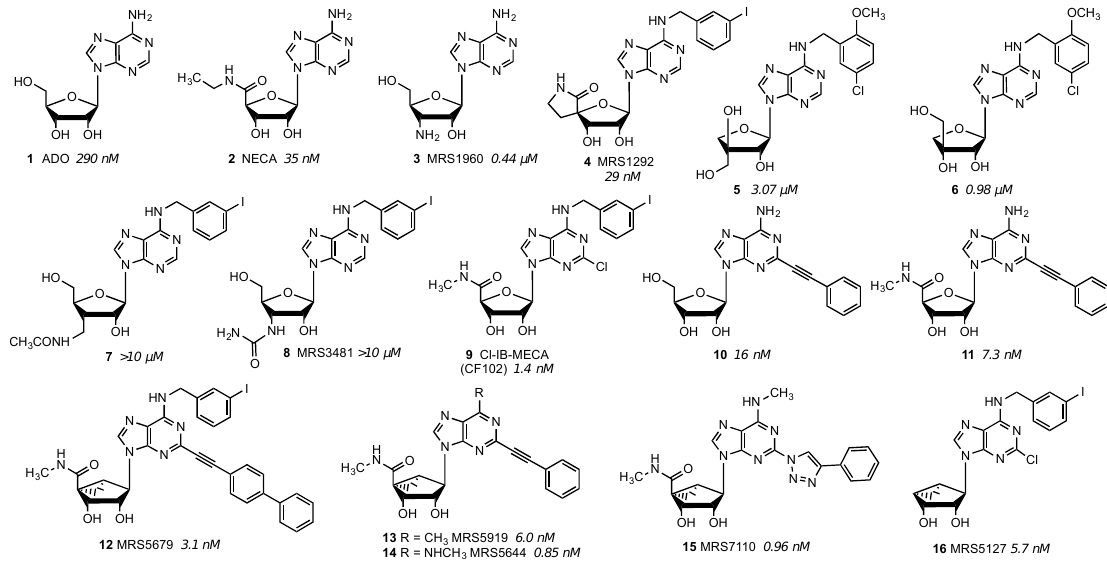
Figure 1. Selected representative adenosine receptor subtype A 3 (A 3 AR) nucleoside ligands, including ribose, modified ribose and ( N ) ‐ methanocarba derivatives (containing a bicyclic substitution of ribose in 12 ‐ 16 that locks the conformation). Ki values in the wild ‐ type human A 3 AR (hA 3 AR) are shown [14,18,21–29]. Most are agonists, but 4 – 6 and 16 display less than full